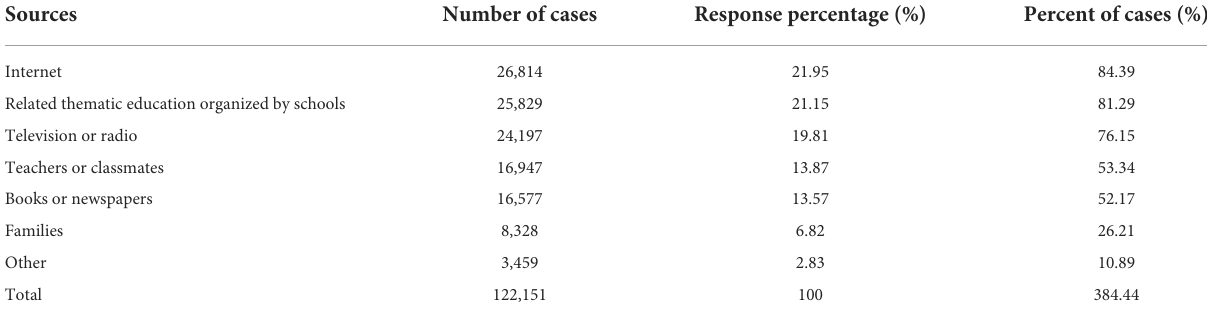
TABLE 12 Main sources of HIV/AIDS knowledge ( n =